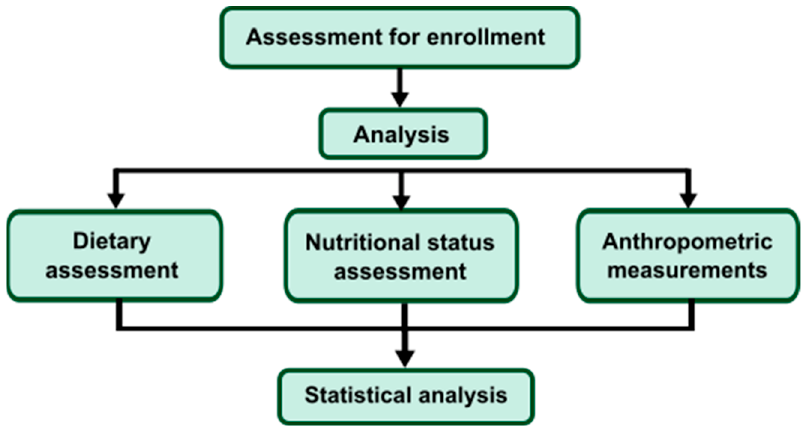
Figure 1. Scheme of the study.